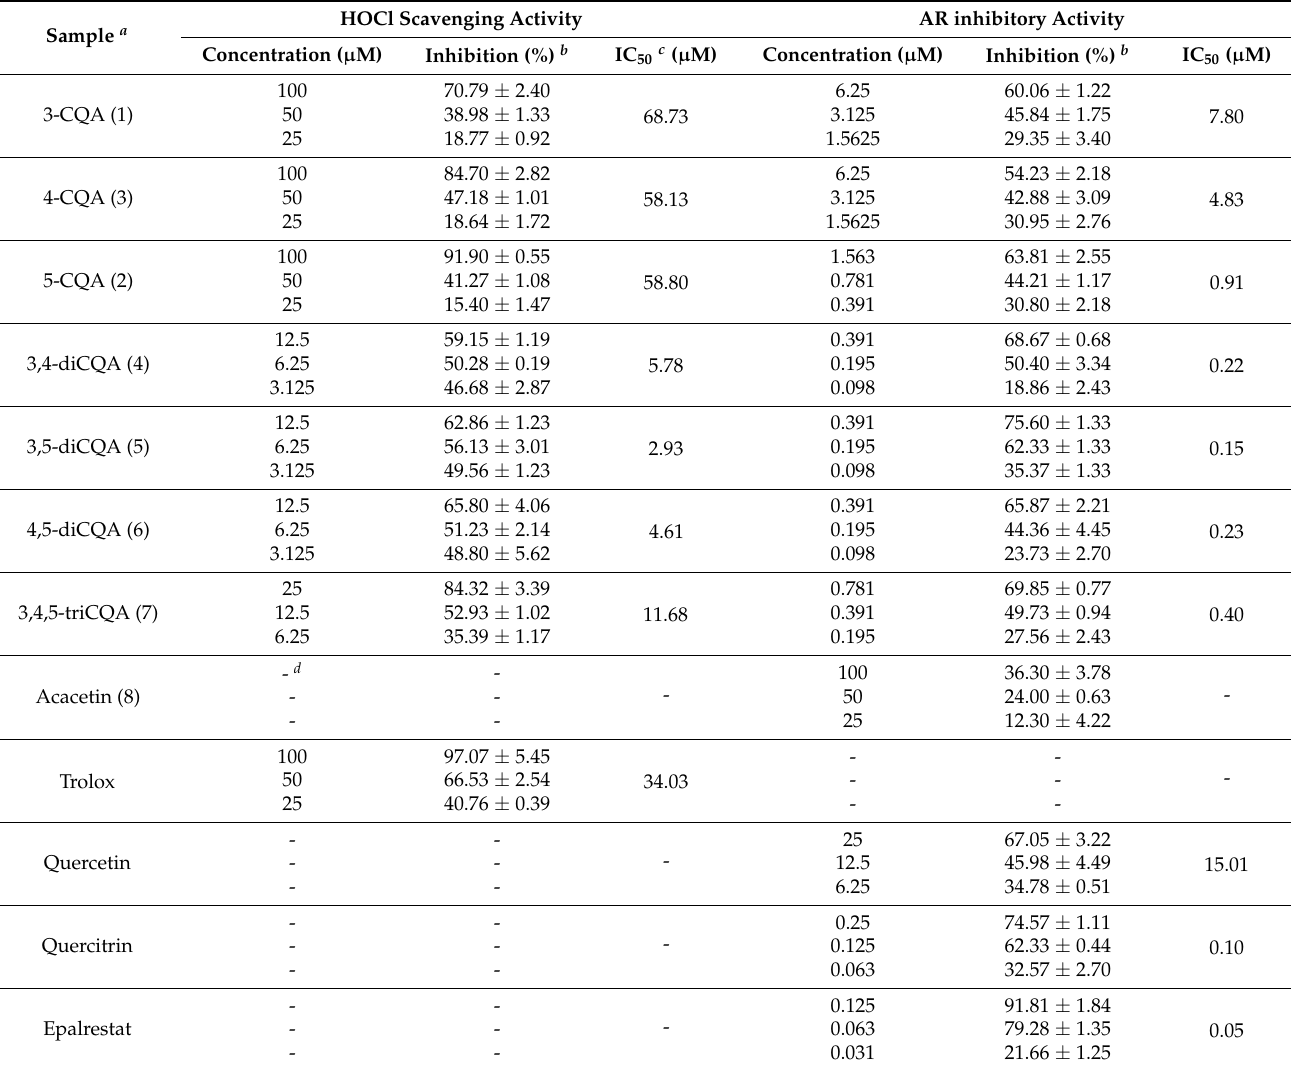
Table 5. Hypochlorous acid scavenging activity and AR inhibitory activity of the components separated from the 70% MeOH root extract of V. rigida